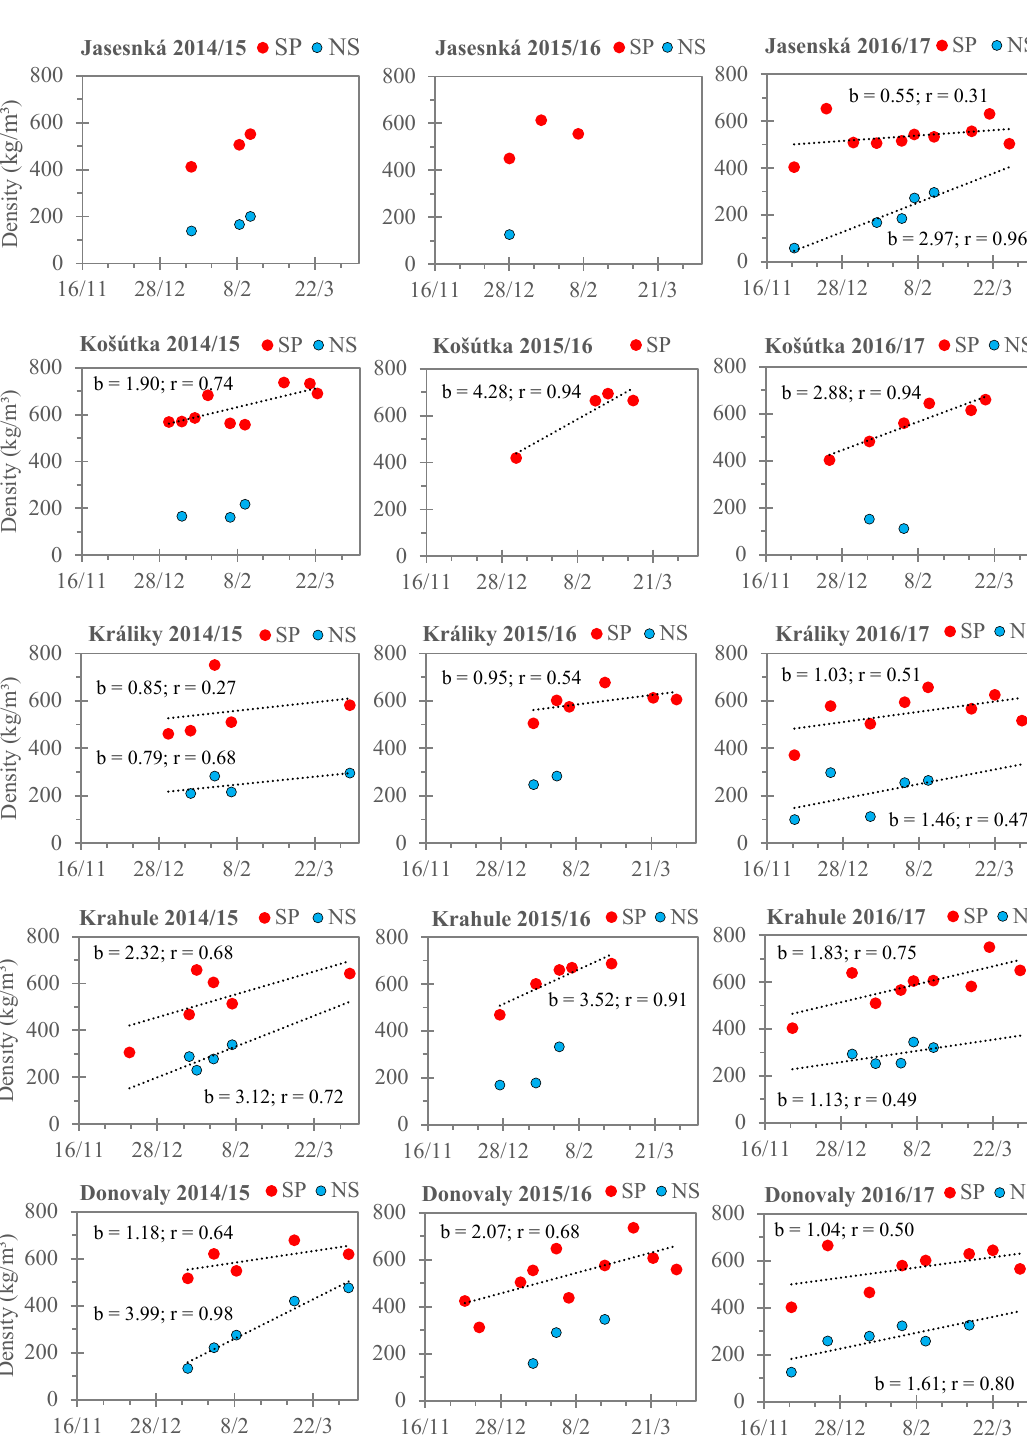
Figure 6. The mean densities of ski piste snow (SP) and uncompacted natural snow (NS) and their increases over three winter seasons (from 2014/15 to 2016/17) at five ski centers. The mean density was calculated from at least five measurements/samples. The slopes of the regression lines (b) indicate the increase in the mean densities of the snow per day, and the correlation coefficients (r) indicates weak (+30), moderate (+50), or strong (+70) linear models. The snow density measurements for SP and NS were paired. The absence of measurements for NS means the absence of natural snowpack on these dates.